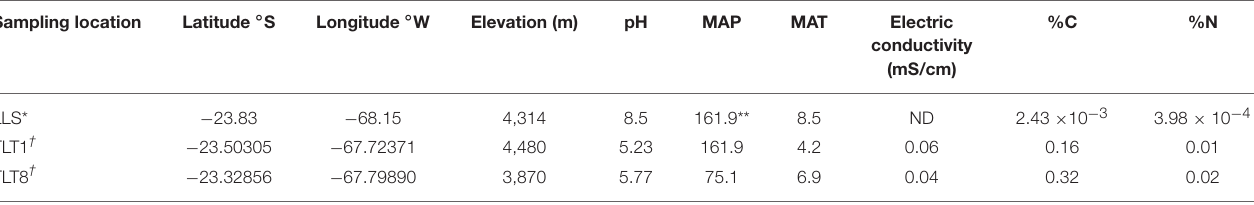
TABLE 1 | Average climatic and soil characteristics of the sites included in this study. Sampling